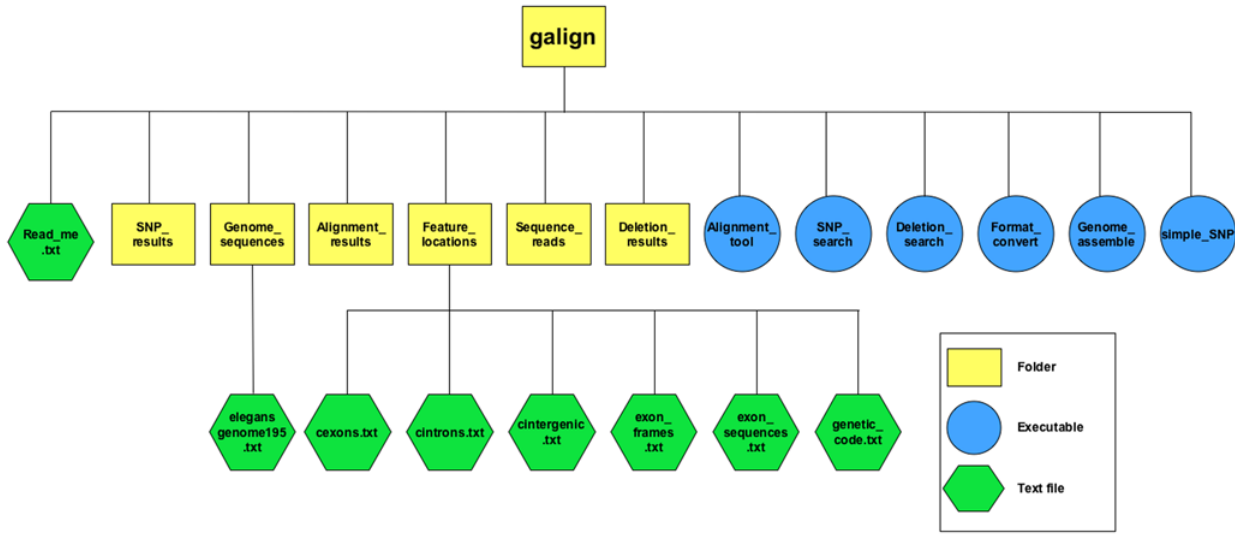
Figure 3. File structure of the ‘galign’ folder. Yellow boxes, folders. Blue circles, executable files. Green hexagons, accessory text files. SNP_results contains the output of SNP_search. Alignment_results contains the output of Alignment_tool. Sequence_reads contains the output of Format_convert. Deletion_results contains the output of Deletion_search. The output of Genome_assemble is located in the Genome_sequences folder. A pre-assembled C. elegans genome (version 195) is distributed with the current software package. Feature_locations contains information about exons, introns and intergenic regions (see text) as well as the genetic code table for amino-acid predictions.